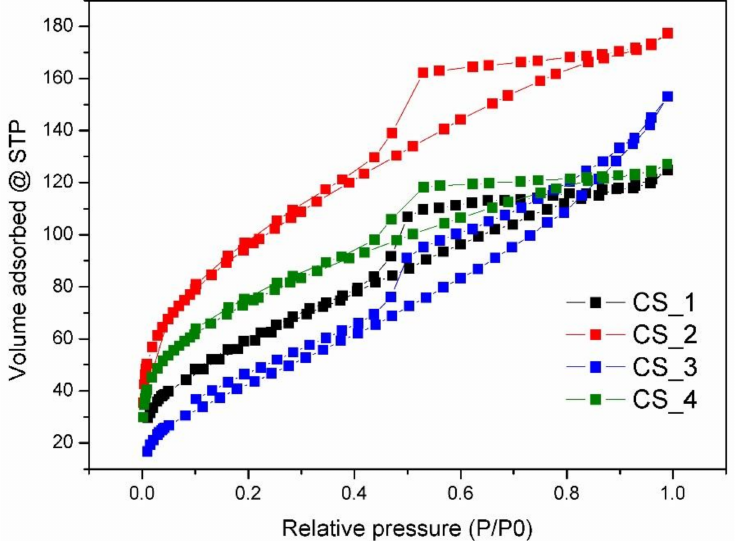
Figure 5. N 2 sorption isotherms of carbon spheres with different times of